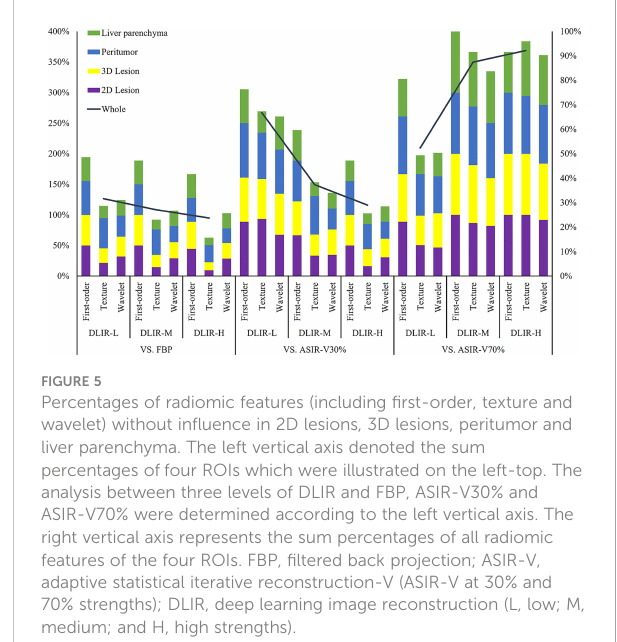
FIGURE 5 Percentages of radiomic features (including fi rst-order, texture and wavelet) without in fl uence in 2D lesions, 3D lesions, peritumor and liver parenchyma. The left vertical axis denoted the sum percentages of four ROIs which were illustrated on the left-top. The analysis between three levels of DLIR and FBP, ASIR-V30% and ASIR-V70% were determined according to the left vertical axis. The right vertical axis represents the sum percentages of all radiomic features of the four ROIs. FBP, fi ltered back projection; ASIR-V, adaptive statistical iterative reconstruction-V (ASIR-V at 30% and 70% strengths); DLIR, deep learning image reconstruction (L, low; M, medium; and H, high